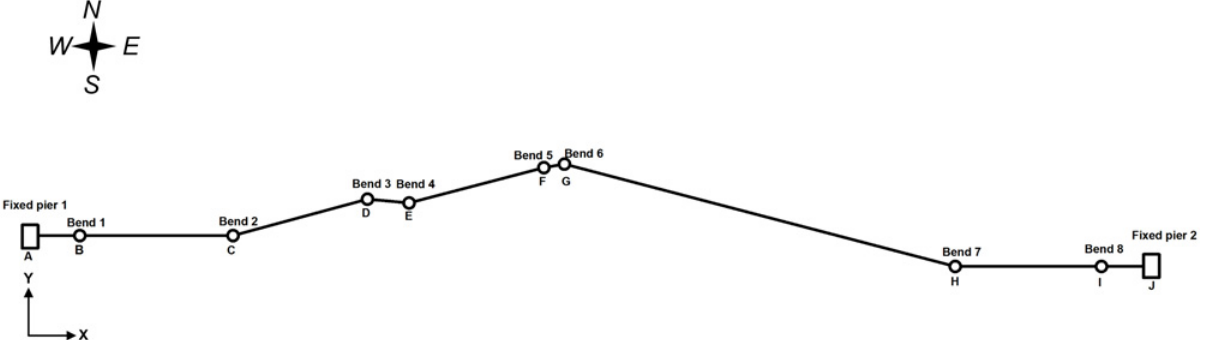
Fig 5. Spatial layout of a pipeline in an earthquake disaster area.